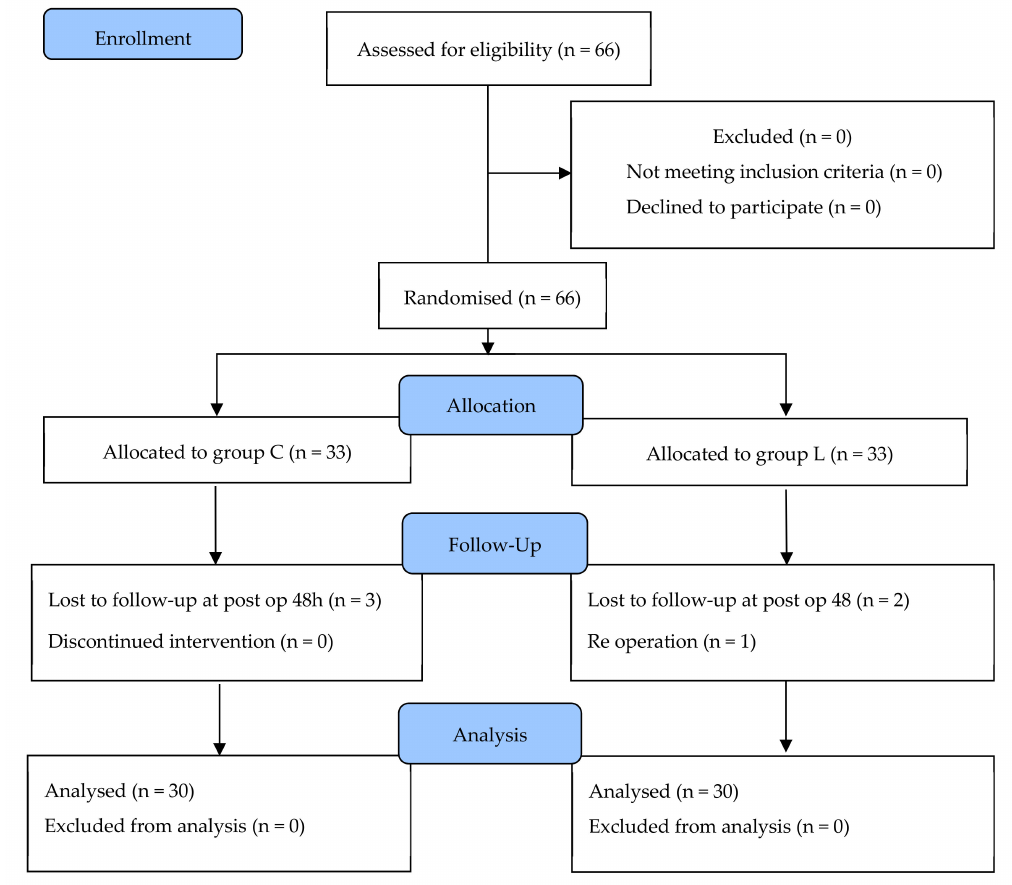
Figure 1. Flow diagram of the